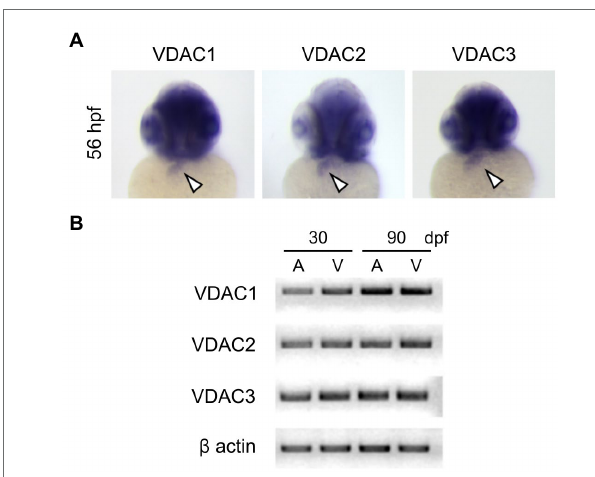
FIGURE 2 | Expression of VDAC isoforms during zebrafish embryonic development. (A) Whole-mount in situ hybridization analysis using full-length riboprobes reveals that all VDAC isoforms are expressed in the embryonic heart (arrowheads). (B) RT-PCR analysis of VDAC mRNA from zebrafish hearts at 30 and 90 days post-fertilization (dpf). Expression of all VDAC isoforms is maintained to adulthood in both the atrium (A) and the ventricle (V).